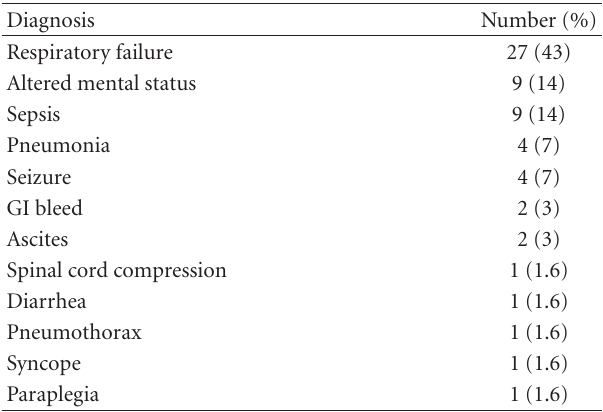
Table 2: Admission